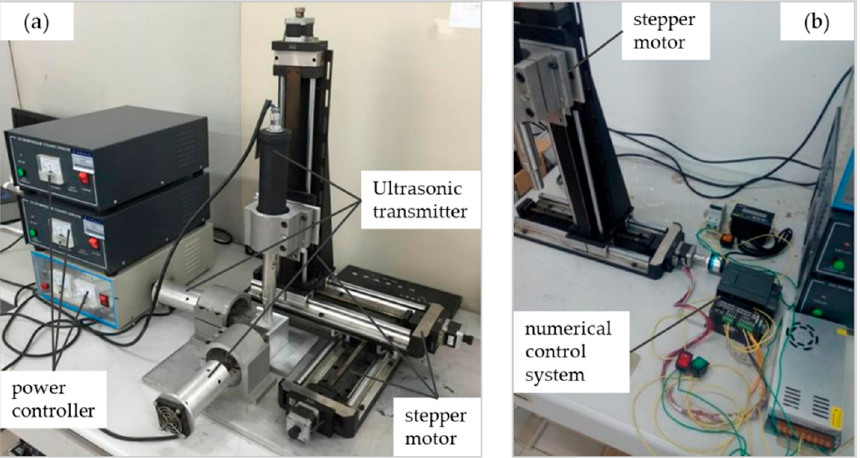
7 of 12 Figure 4. ( a ) Diagram of the solid medium triaxle acoustic levitation device; ( b ) Diagram of the schematic design of the acoustic levitation control system. Three ultrasonic generator parameters are the same; frequency is f = 30 kHz, power is p = 300 W, and amplitude is A = 30 μ m. Zolix’s TSA200-E ball screw guide rail is selected as the motion device of the three-dimensional acoustic levitation system. Each guide rail is responsible for a direction of freedom. The ultrasonic transmitter is fixed on the slider